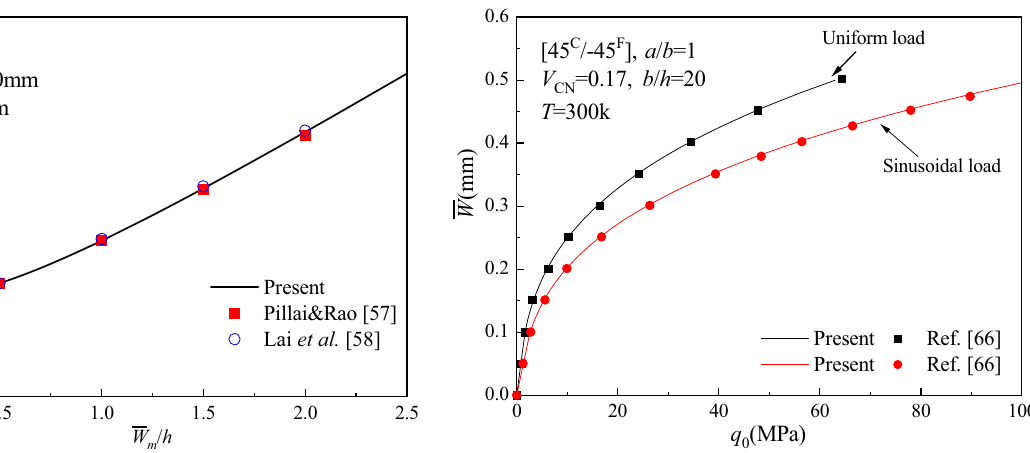
Figure 4: Comparisons of ω NL / ω L for angle - ply ( 0/90 ) 3T laminated plate.